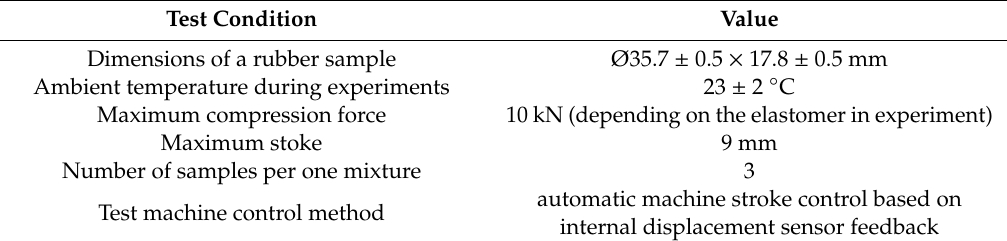
Table 4. Specification of experimental uniaxial compression of rubber samples.